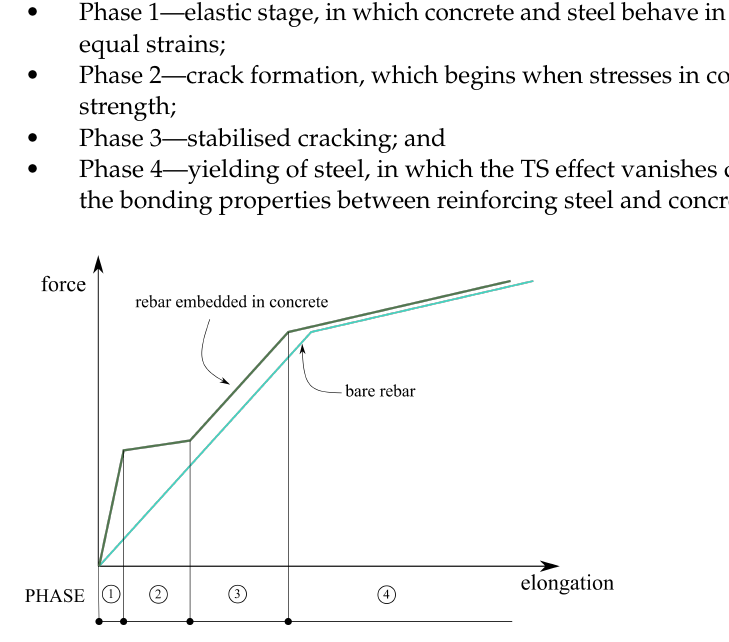
Figure 9. Typical force—elongation curve for reinforcement bar embedded in concrete. 1—elastic stage, 2—crack formation, 3—stabilised cracks, 4—plastic